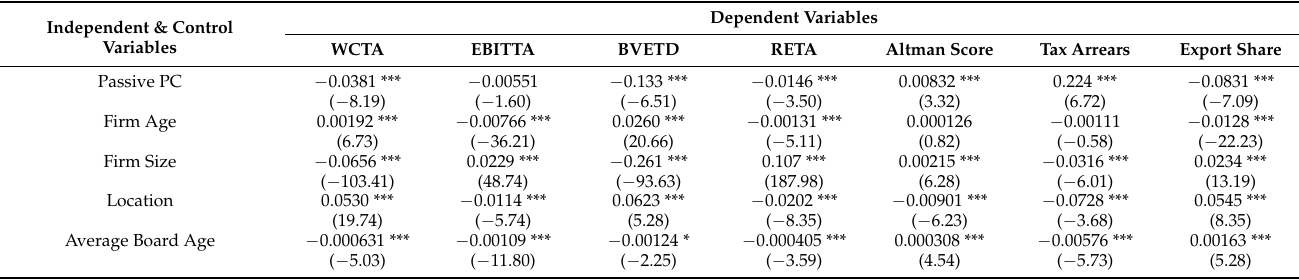
Table A2. OLS regressions with seven different dependent variables (year 2017) and Passive PC as the independent